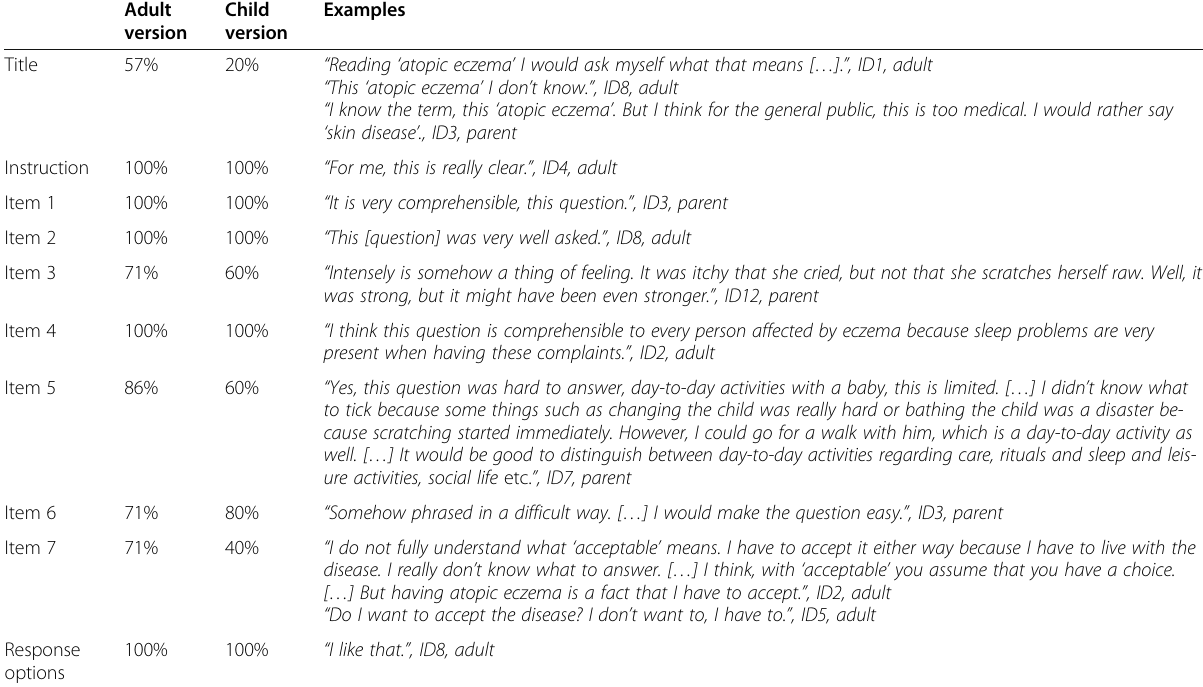
Table 2 Percentage of participants reporting comprehensibility of the title, instructions, items, and response